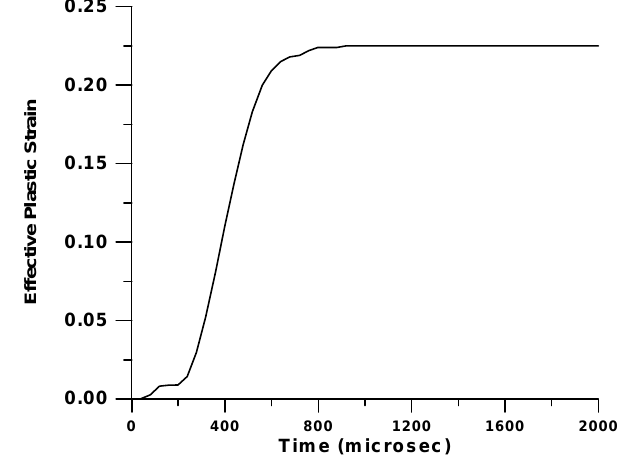
Fig. 8. Typical effective plastic strain time history